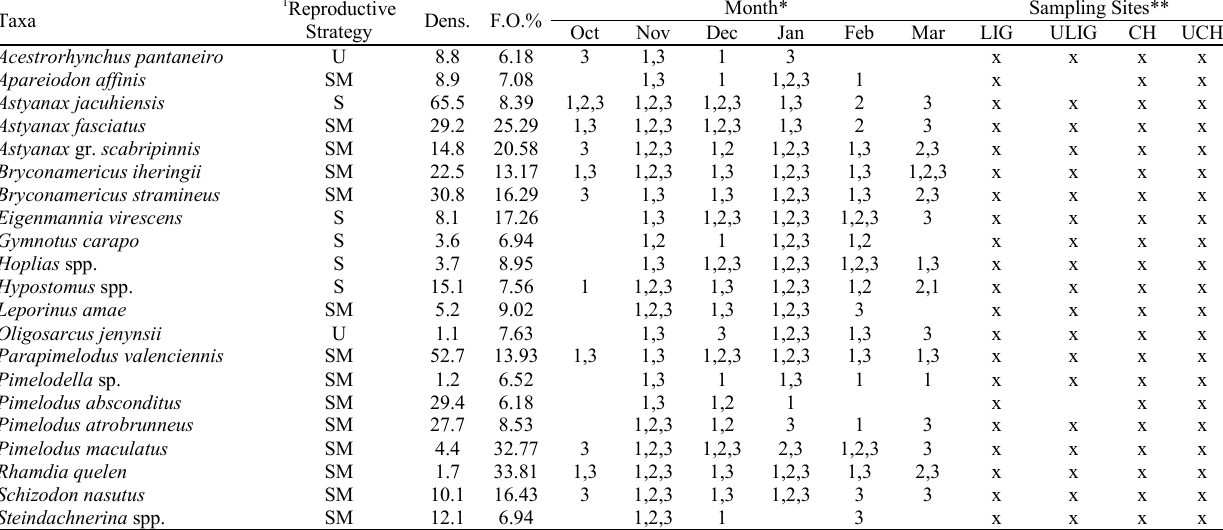
Table 1 . Composition, average density (larvae.10 m -3 ), frequency of occurrence (F.O. %) and the occurrence of fish larvae collected in different months and sampling sites in the upper Uruguay River from October 2001 to March 2004. * 1= RP1; 2= RP2 and 3= RP3. ** X= Indicates the presence in the sampling sites: LIG: Ligeiro, ULIG: Uruguay-Ligeiro, CH: Chapecó,